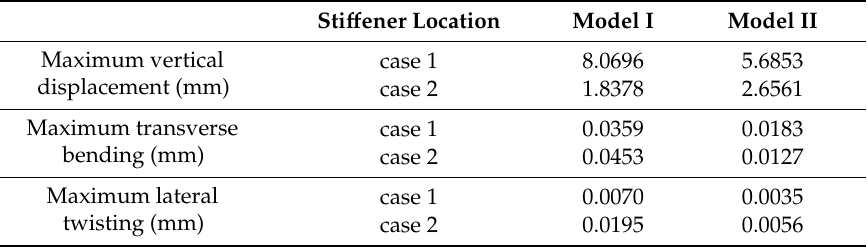
Table 5. Maximum responses of two models for LQR control.